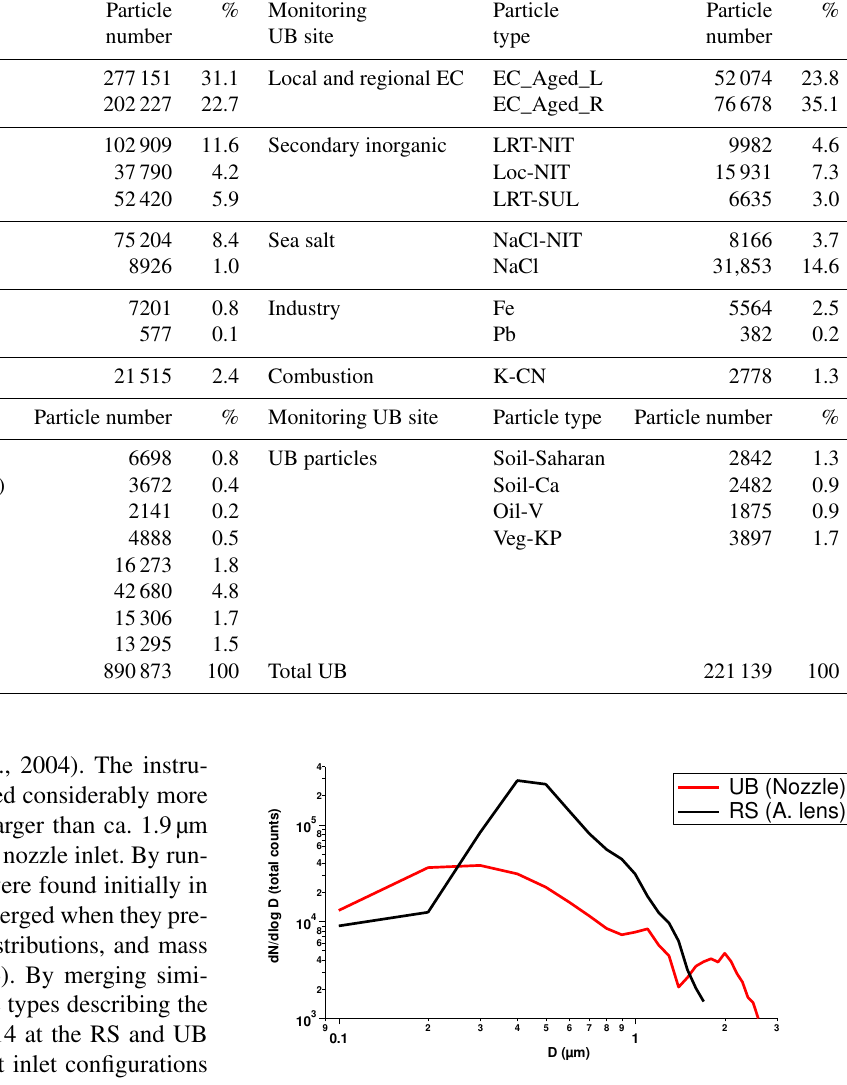
Figure 1. Size distributions of collected ATOFMS particles at the two SAPUSS monitoring